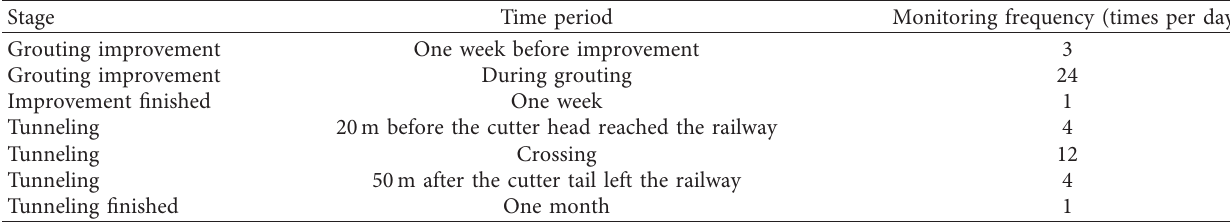
Figure 10: Planar view of the monitoring point layout. Table 6: Monitoring frequency.